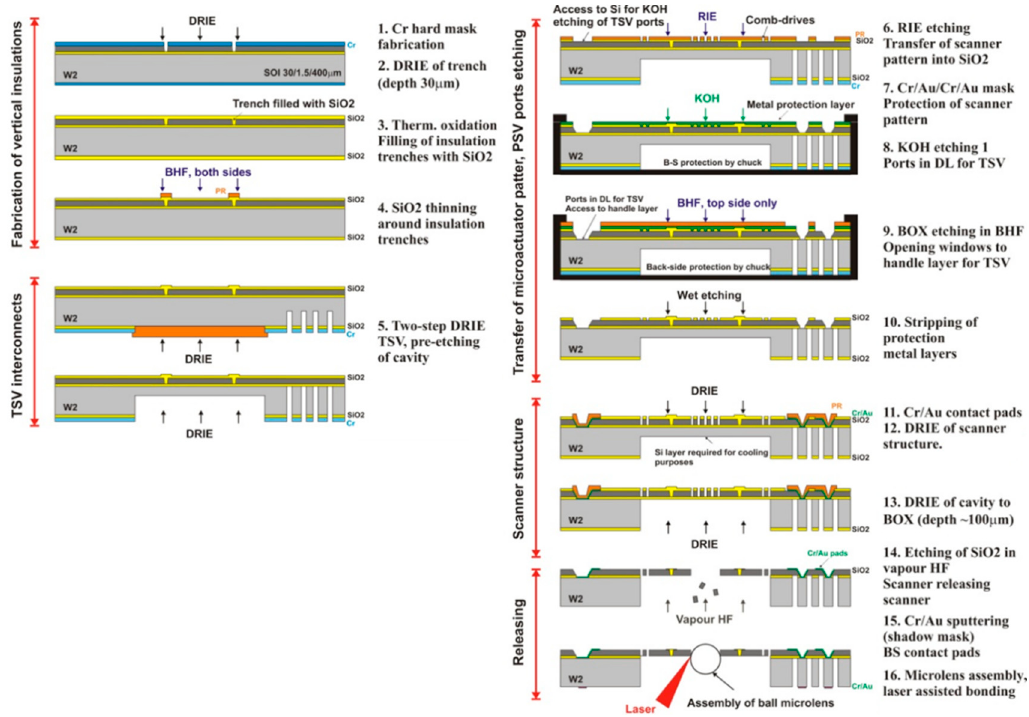
Figure 11. Flow-chart of the x-y scanner.